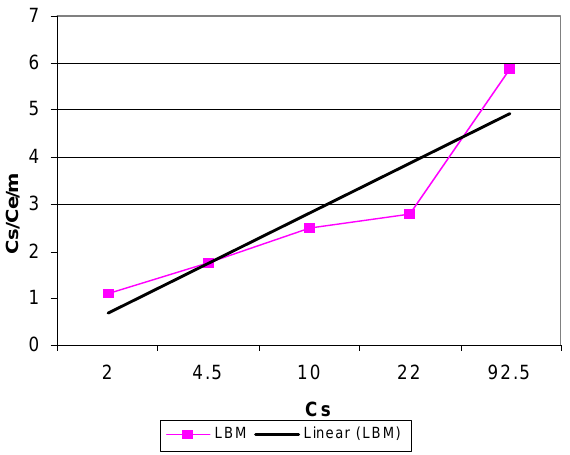
Figure 12: Langmuir Adsorption Isotherm For Batch Study using LBM Table 1: Freundlich Adsorption